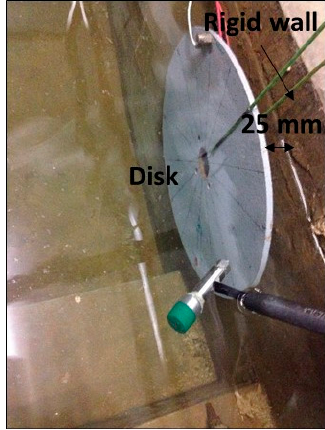
Figure 5. Tested Structure (disk) submerged in water with a nearby rigid wall.